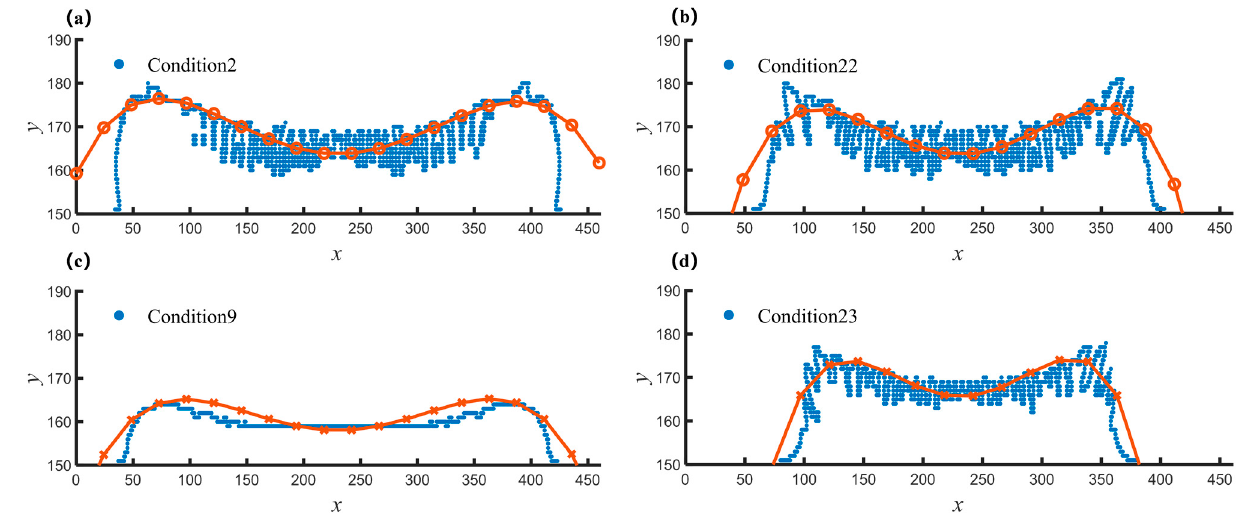
Figure 11. Examples of parameters control for desired morphology. ( a ) Sediment profile and fit line for condition 2 at 500,000 time steps; ( b ) Sediment profile and fit line for condition 22 at 500,000 time steps; ( c ) Sediment profile and fit line for condition 9 at 500,000 time steps; ( d ) Sediment profile and fit line for condition 23 at 500,000 time